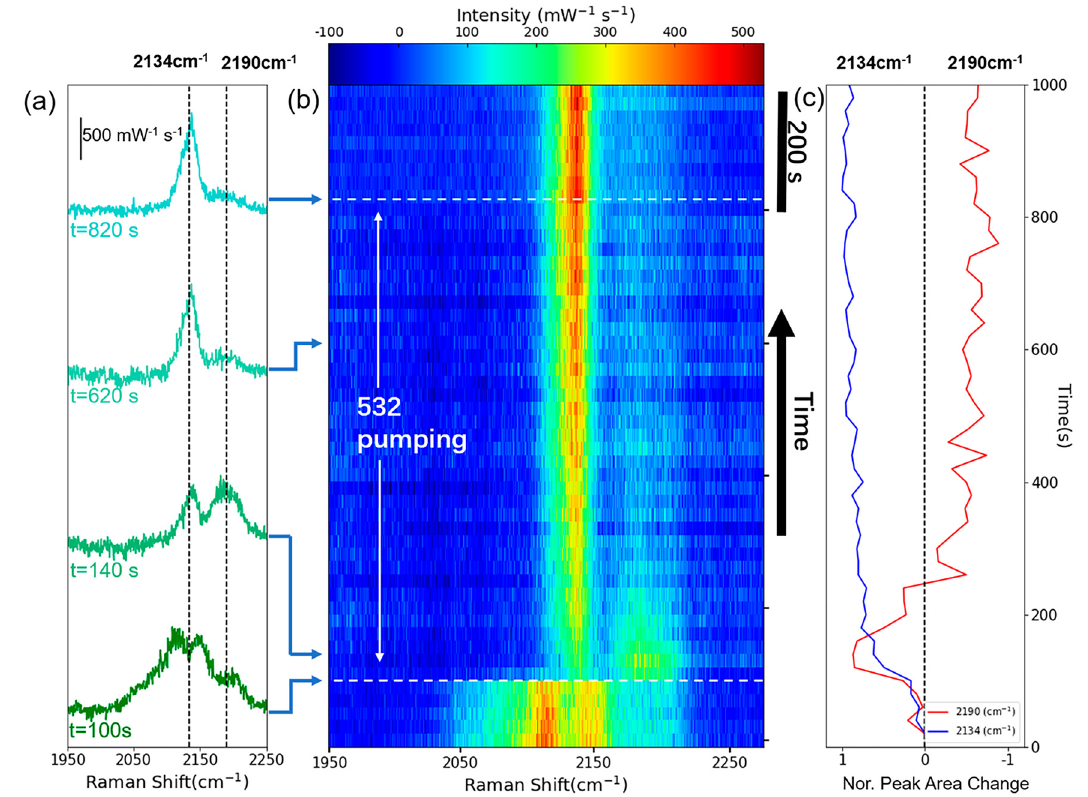
Figure 2: In situ spectrum of ferri/ferrocyanide reaction on AuNPs. (a) SERS spectra at different time points ranging from 100, 140, 620 to 820 s. (b) Stacking of SERS spectra with time at 785 nm laser beam, spectral changes were observed after the 532 nm optical pumping was turned on. (c) Peak area changes with time of bands at 2190 and 2134 cm − 1